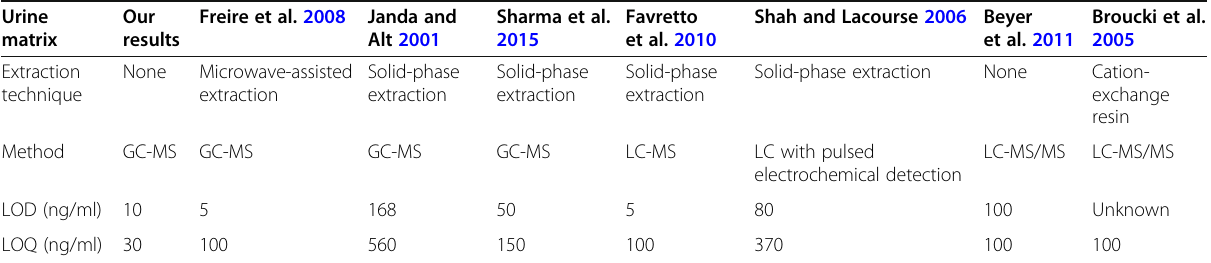
Table 4 A comparison of the LOD, LOQ, extraction techniques, and instruments used in our study and other published methods Urine Our Freire et al. 2008 Janda and Sharma et al. matrix results Alt 2001 2015 Extraction